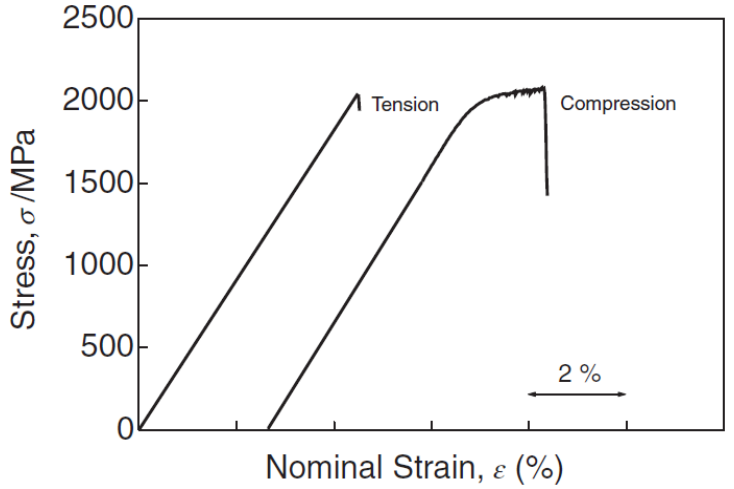
Figure 11. Stress–strain curves of BMG samples obtained by tension and compression tests. Reproduced with permission from [99]. Copyright 2004, The Japan Institute of Metals and Materials.